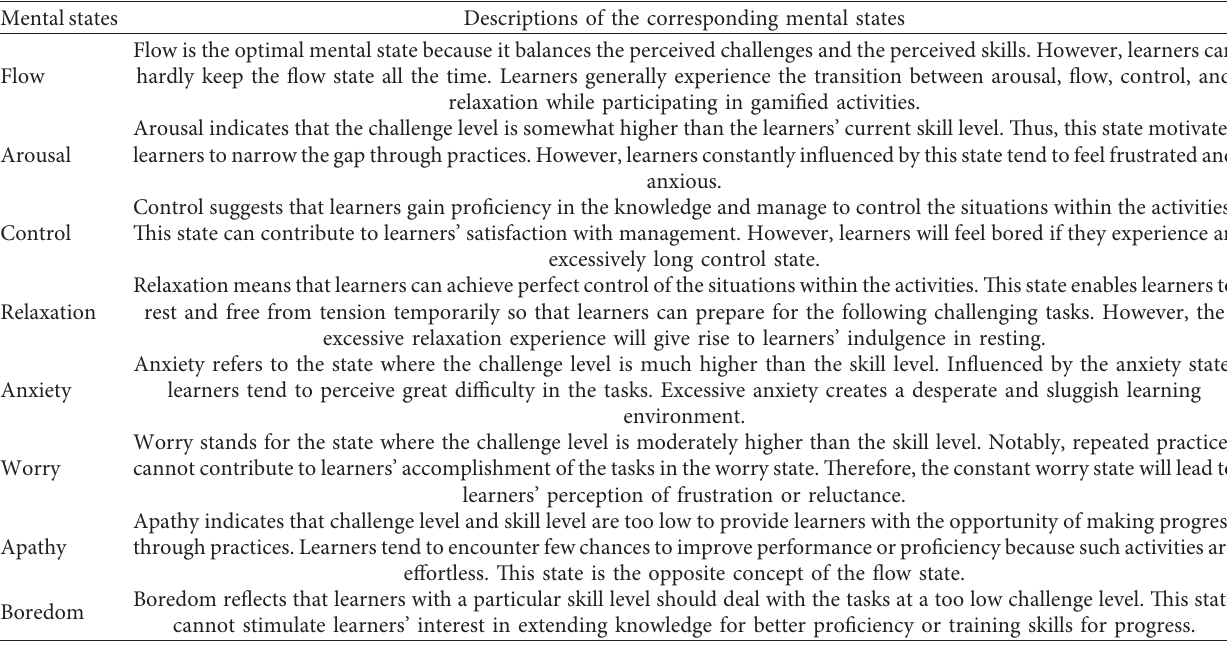
Table 3: The eight mental states influenced by the relation between challenge levels and skill levels [64]. Mental states Descriptions of the corresponding mental states Flow Arousal Control Relaxation